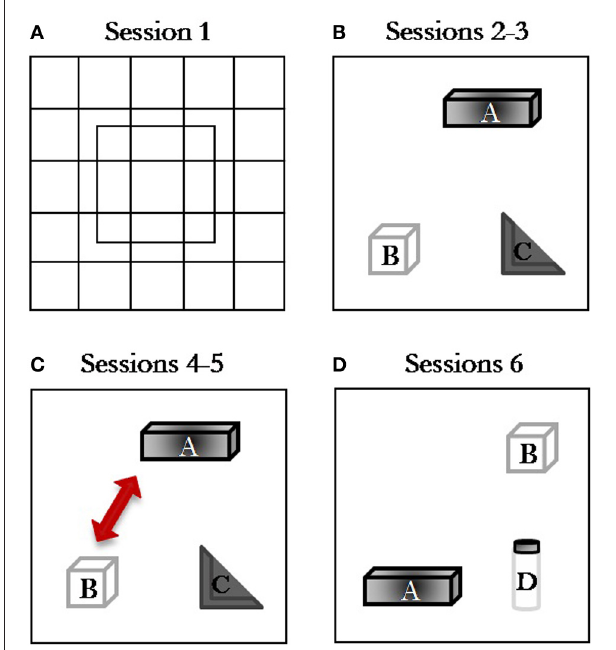
FIGURE 2 | Effects induced by different arousal conditions on locomotor activity and emotional behavior of vehicle-treated rats. Locomotor activity: number of crossing (A) and rearing (B) in session 1. Emotional behavior: time spent in the center of the arena in session 1 (C) . ** P < 0.01. Data are expressed as mean ± SEM. (High Arousal: HA n = 10; Low Arousal: LA n =